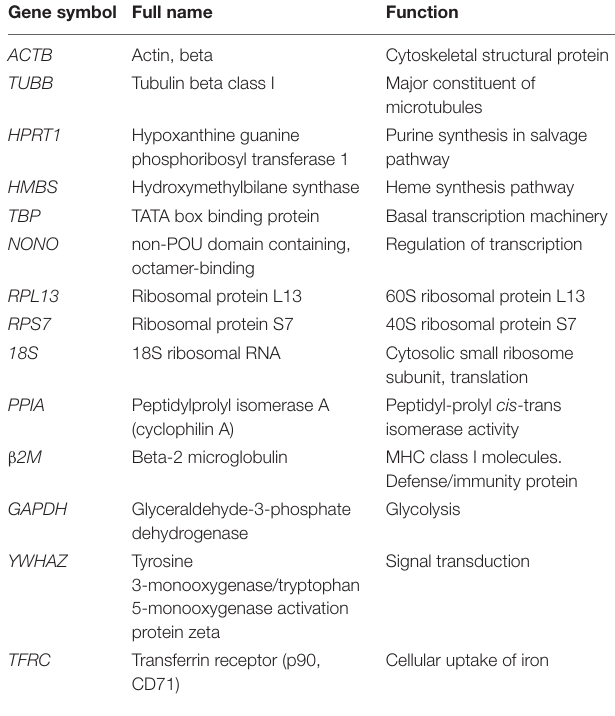
TABLE 1 | Information of the 14 reference